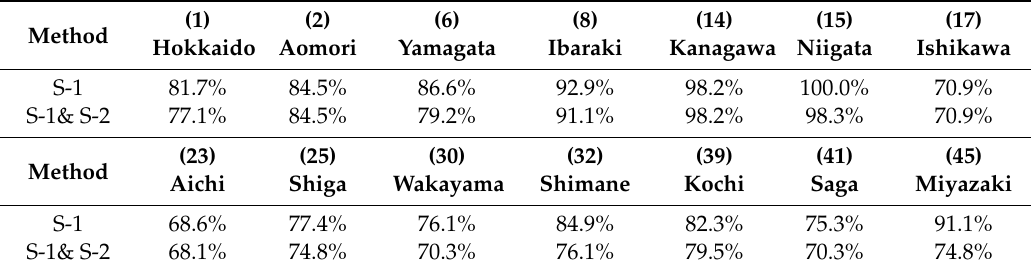
Table 2. Producer’s accuracies in each of the 14 “Paddy” reference field regions (30 m pixel-scale resolution). See Figure 2a for reference field region locations.